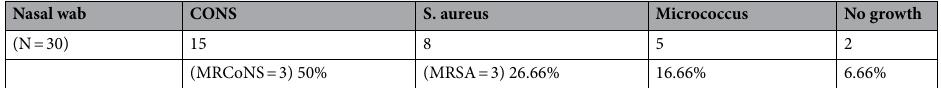
Table 3. Nasal Carriage of micro-organism in Health care workers of PICU. Micro-organism isolated from anterior nares of health care workers. The organisms which were isolated are CoNS (15/30), S.aureus (8/30), and Micrococcus